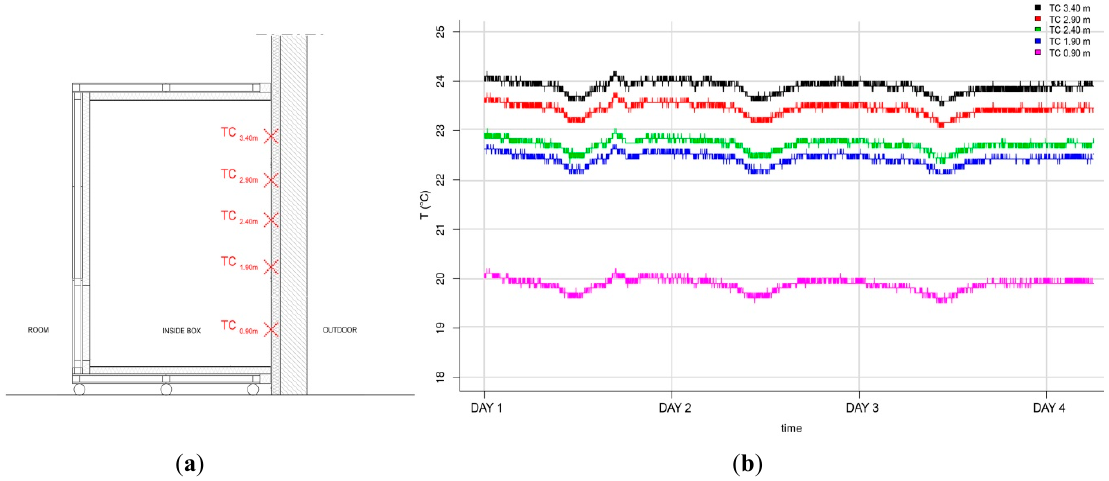
Figure 7. Results of the simplified test to evaluate the heat stratification inside the box: ( a ) Vertical section of the metering box with the position of the TCs; ( b ) plot of the monitored T value of the five survey points (TC).